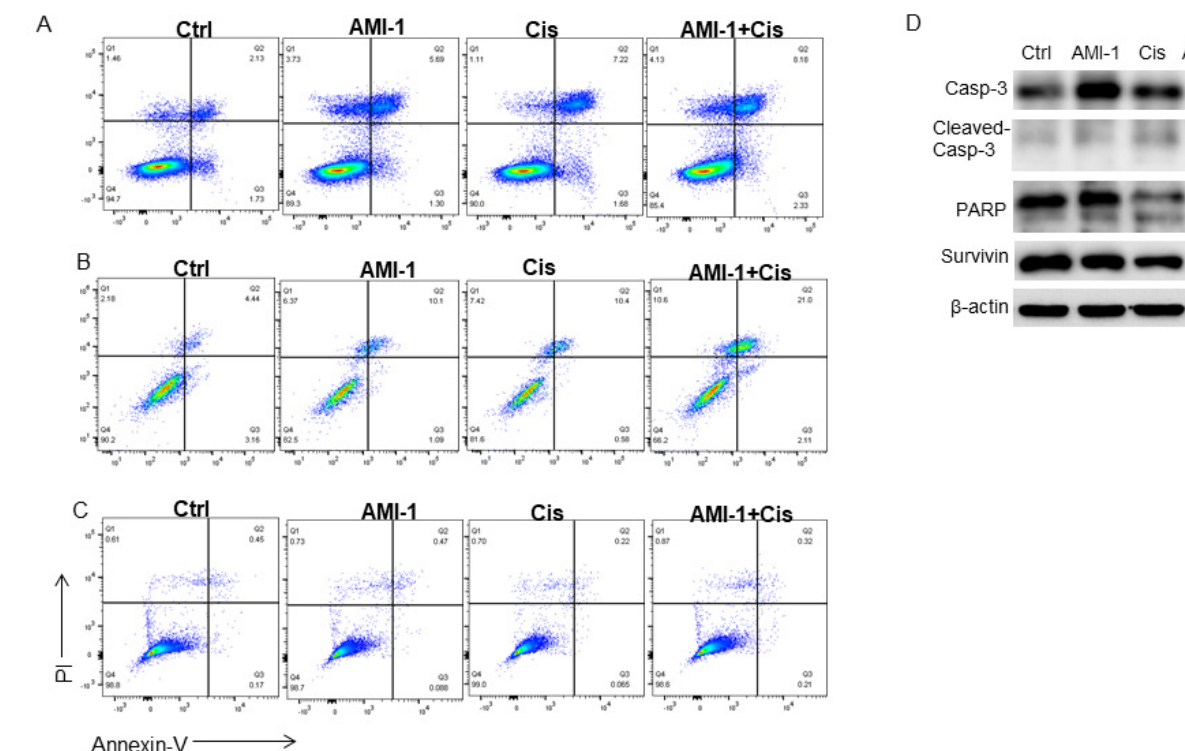
Figure 5. AMI-1 in combination with cisplatin augments apoptosis in lung cancer cells but not in HBEpC cells. A549; DMS 53 and HBEpC cells were cultured in the presence of AMI-1; cisplatin or both for 72 h. ( A ) A549 cells were stained with annexin V-FITC/PI and apoptosis read using flow cytometry. Flow cytometric acquired data were analyzed using the FlowJo software. ( B ) DMS 53 cells were stained with annexin V-FITC/PI and apoptosis read using flow cytometry. ( C ) HBEpC cells were stained with annexin V-FITC/PI and apoptosis read using flow cytometry Flow cytometric plots demonstrate 10 µ M AMI-1 in combination with cisplatin selectively induced apoptosis post 72 h of treatment in both lung cancer cells, not HBEpC cells. Data are from one representative experiment out of at least three. ( D ) Representative Western blot of caspase-3; PARP; and survivin levels in A549 cells after administration of AMI-1 and/or cisplatin for. ß-actin was used as the loading control.